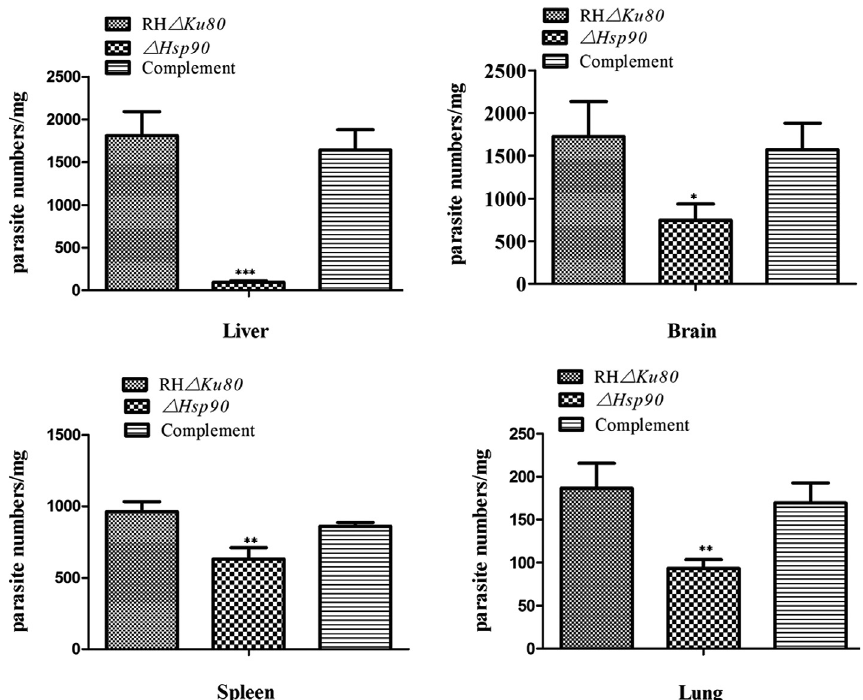
Figure 8. Analysis of parasite burden in BALB/c mice. The parasite burden was also detected in infected mice when the symptoms of T. gondii infection appeared. Parasite burden was detected in liver, brain, spleen, and lung tissues. The data were means ± SD for three experiments. * p < 0.05, ** p < 0.01, *** p <